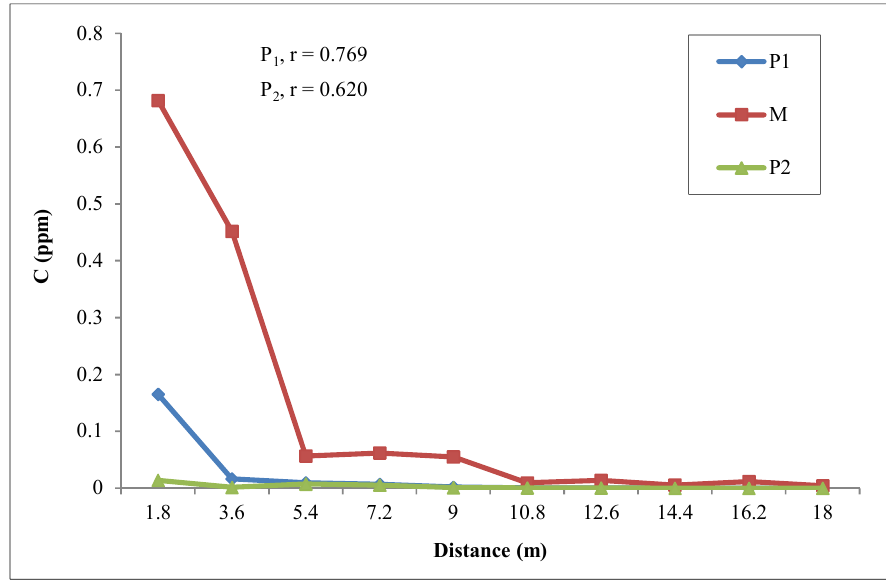
Figure 10. Measured and Predicted Concentrations against Distance for the month of